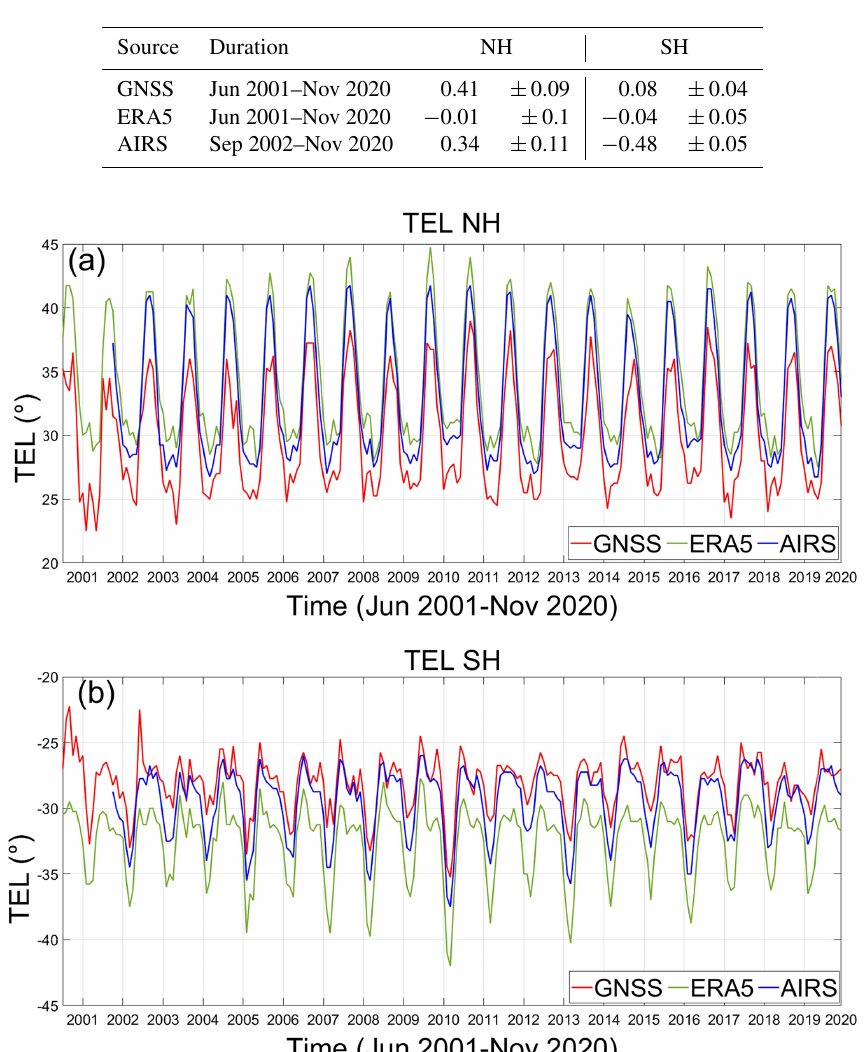
Figure 6. TEL using a subjective criterion for the (a) NH and (b) SH.